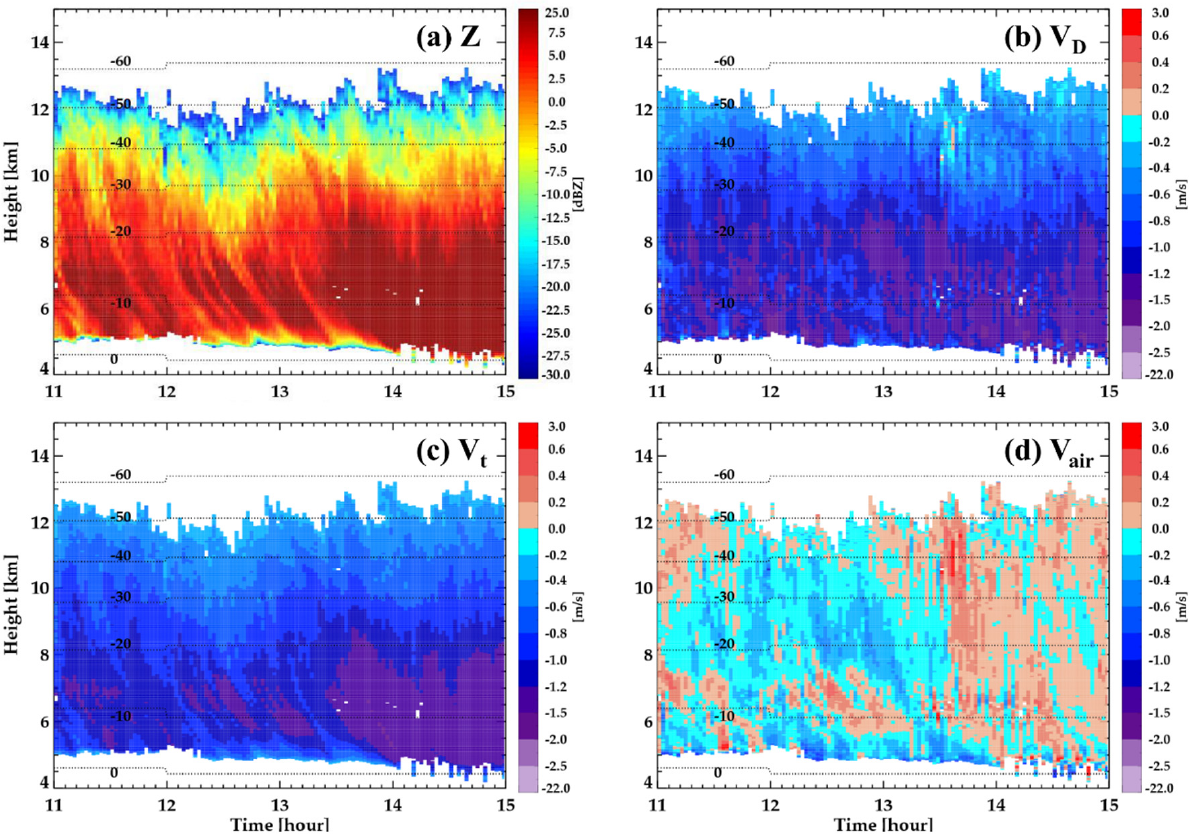
Figure 13. Time–height cross-sections of ( a ) observed Z , ( b ) observed V D , ( c ) V t retrieved from V t – Z relationship of anvil, and ( d ) retrieved V air of a case of anvil on 16 June 2014. Dotted line is temperature from sounding data.